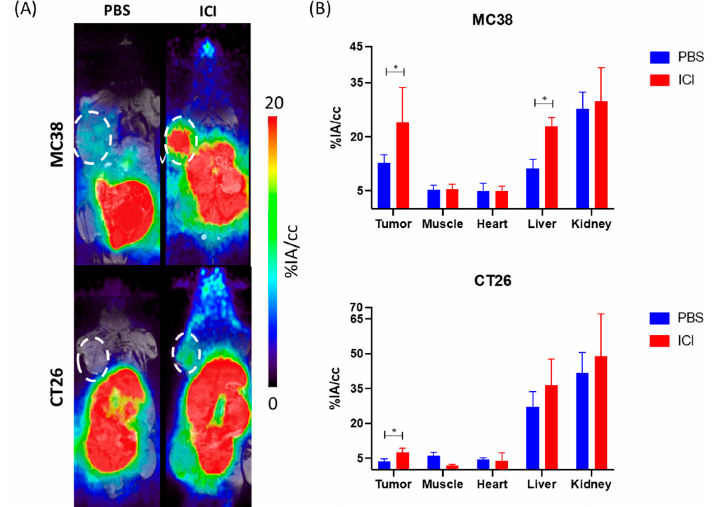
Figure 1. ( A ) Representative PET/MR MIP images of CT26 and MC38 tumor-bearing mice with and without ICI treatment (1 h post injection of 68 Ga-NOTA-GZP). ( B ) Uptake values of blood pool and major organs, showing significantly higher tumor uptake with ICI, represented as %ID/g. * p <